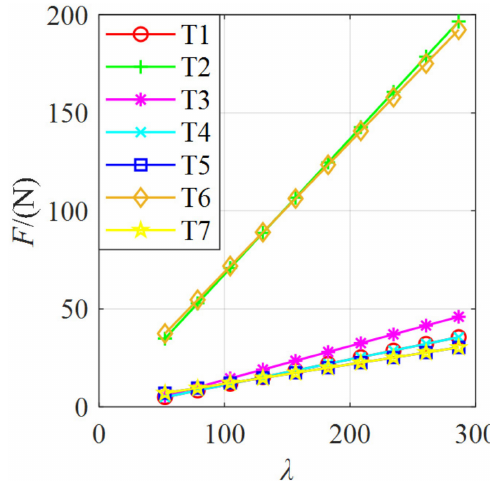
Figure 9. Tension changes of the seven cables within the value range of λ